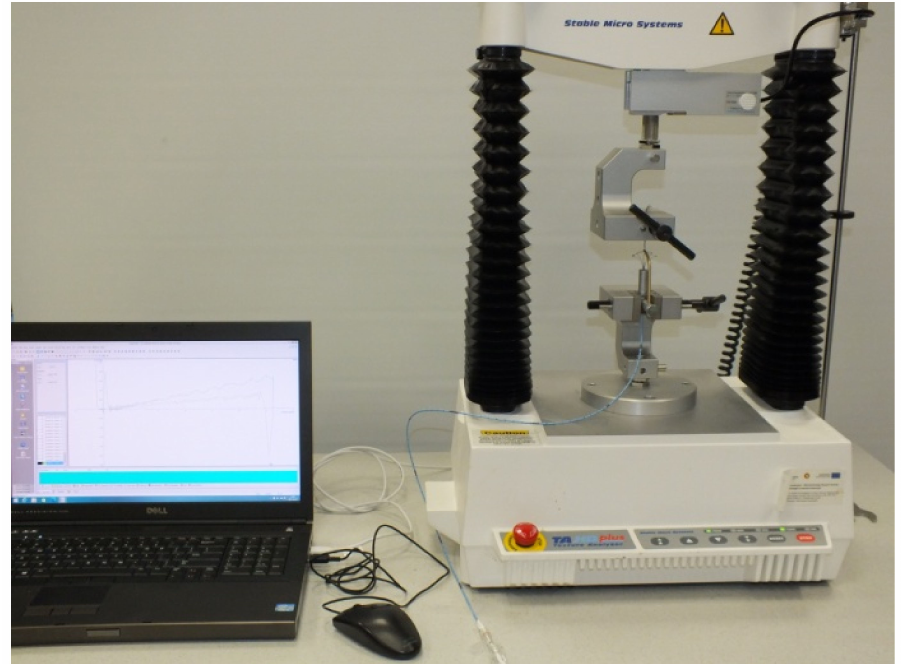
Figure 4. View of the measurement